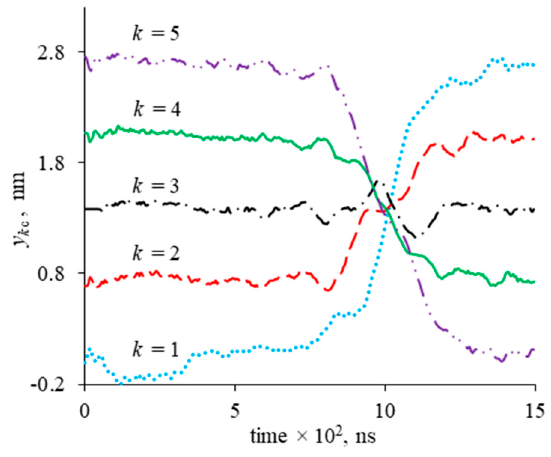
Figure 2. Time dependence of the y -coordinates of the centers of mass of nanotori at S = 5.